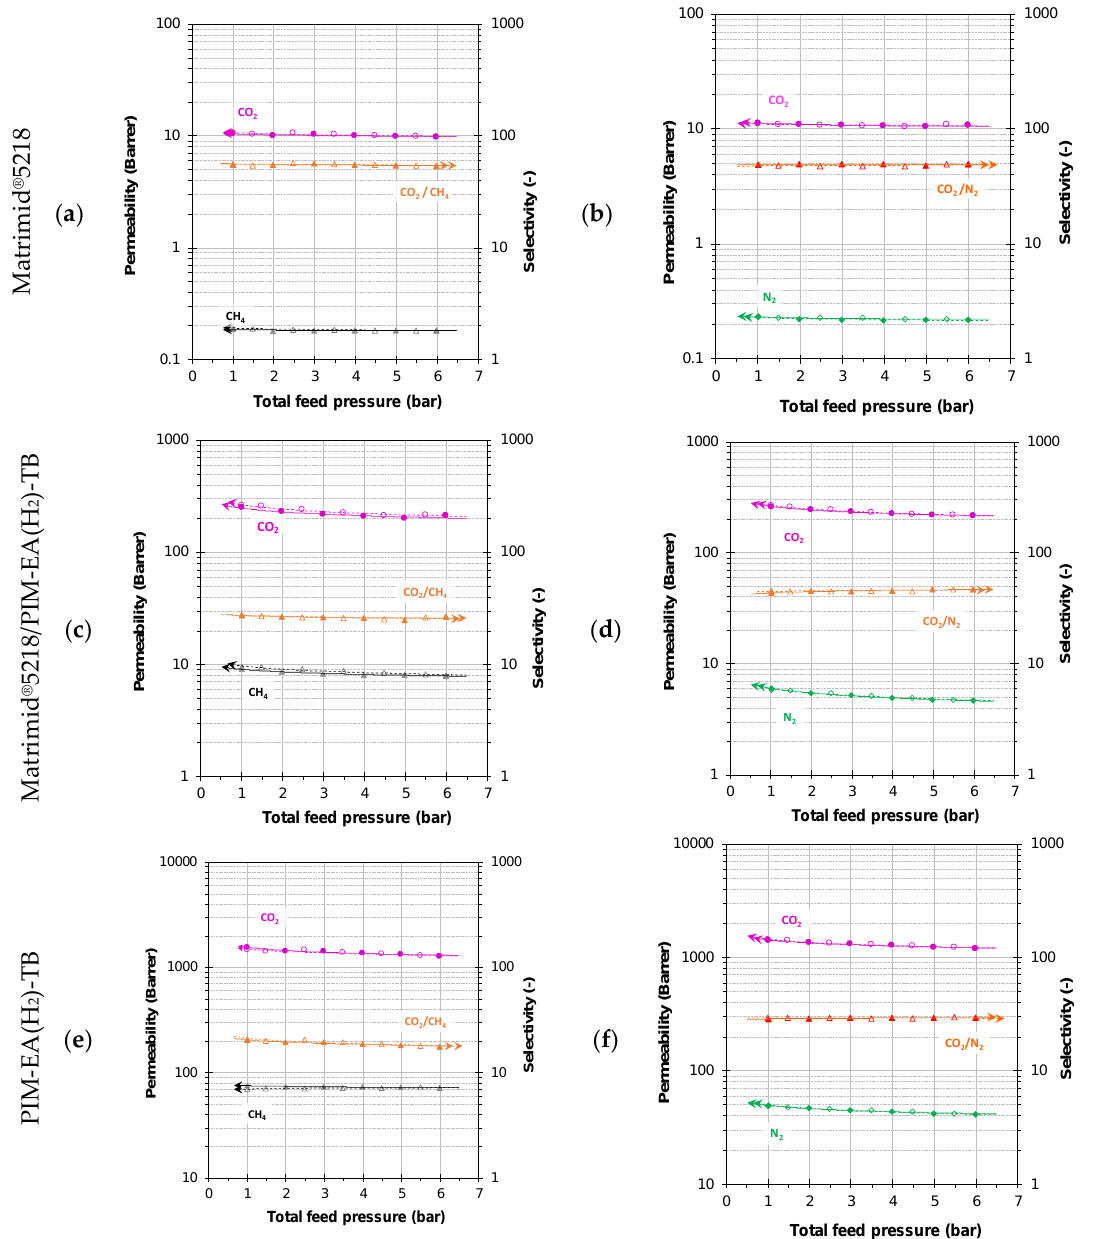
Figure 4. ( a , c , e ) Pressure dependence of CO 2 and CH 4 permeabilities and CO 2 /CH 4 selectivity using the binary mixture of CO 2 /CH 4 (35:65 vol %) for neat polymers and Matrimid ® 5218/PIM-EA(H 2 )-TB blend membranes. ( b , d , f ) Pressure dependence of CO 2 and N 2 permeabilities and CO 2 /N 2 selectivity in binary mixtures CO 2 /N 2 (15:85 vol %); Closed symbols are used for the stepwise increase of the pressure and open symbols for the subsequent stepwise decrease of the pressure.